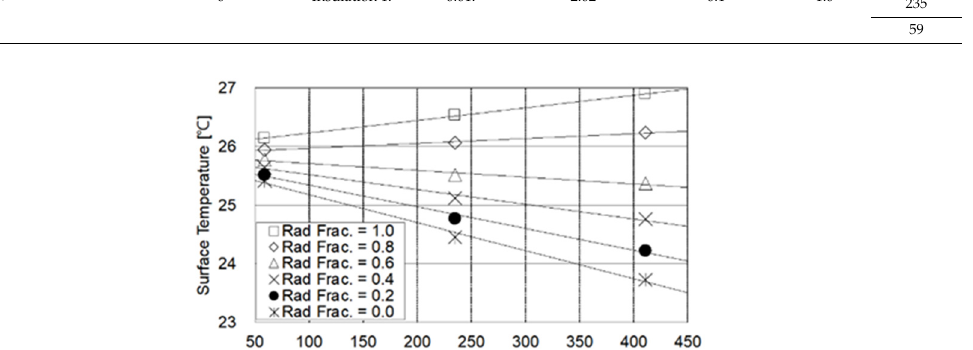
Figure 14. Internal heat gain and surface temperature for radiant fraction (unexposed to outdoor air).